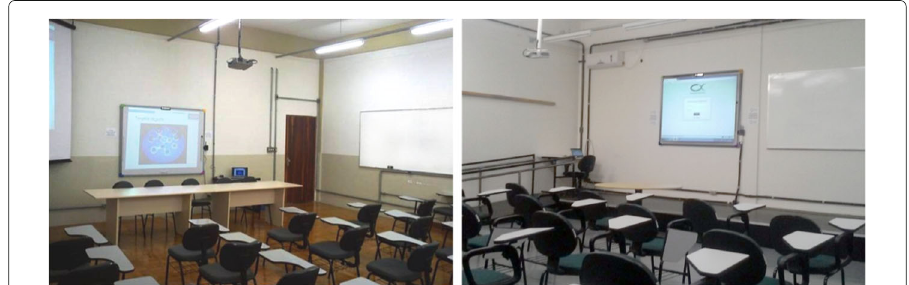
Fig. 1 Instrumented Classroom for Ubiquitous Learning Environment (Araújo et al.